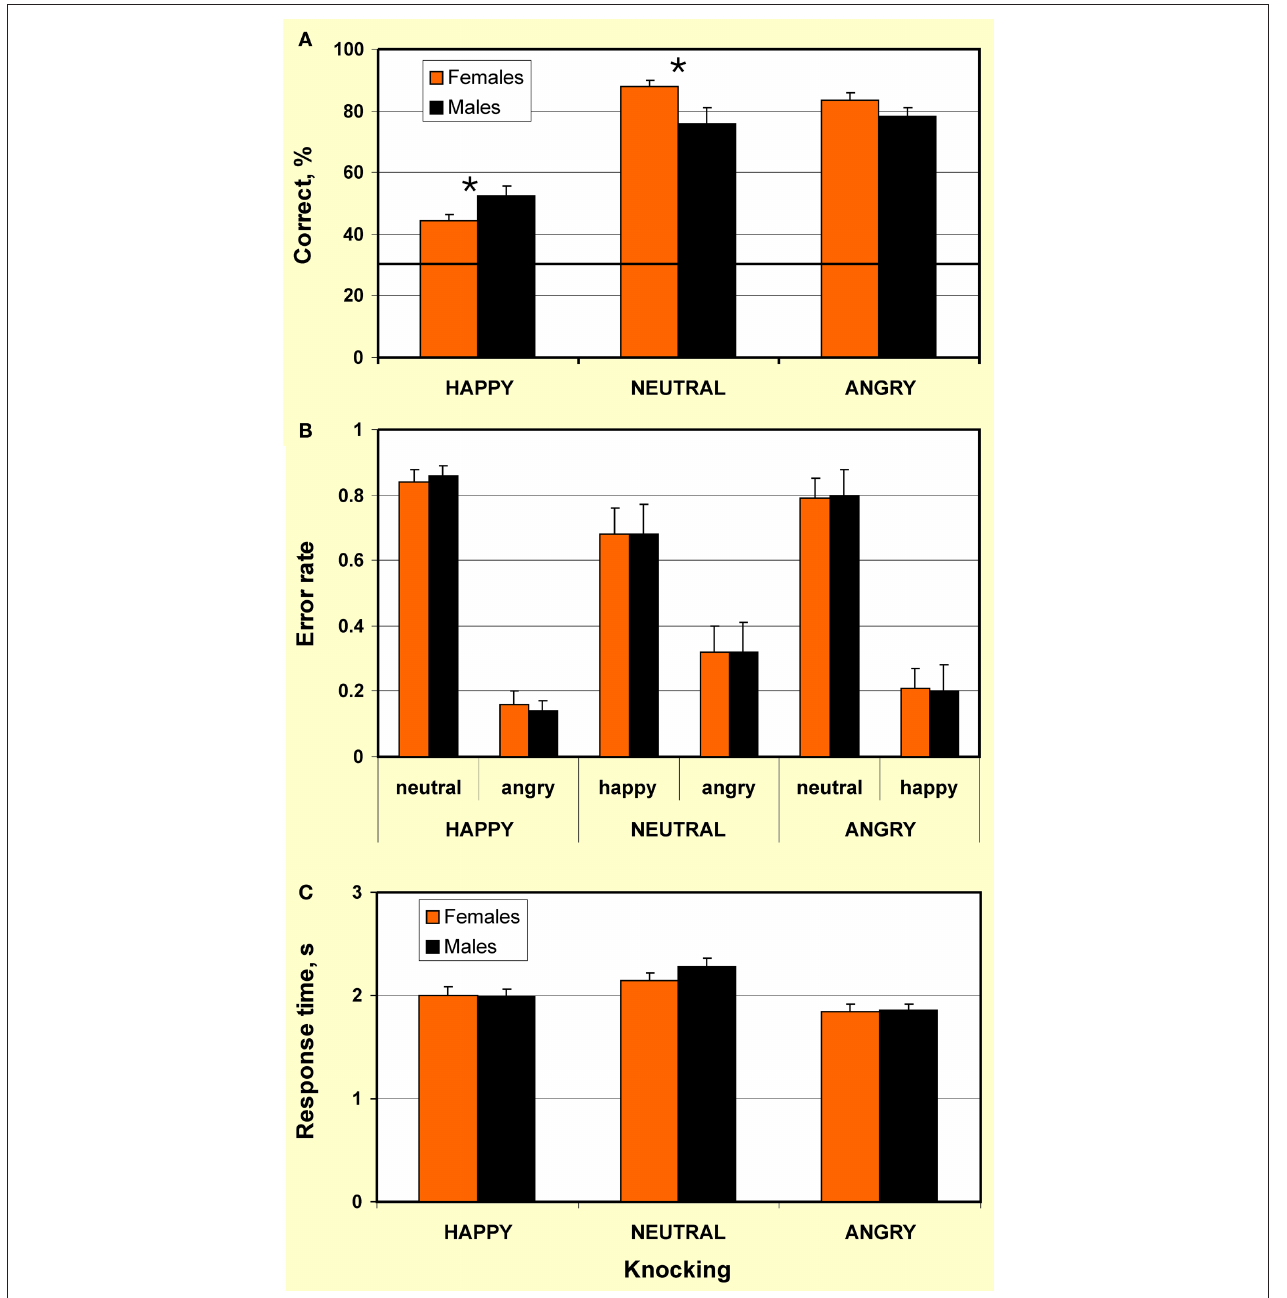
Figure 2 | recognition of happy, neutral, and angry point-light knocking by females and males. (A) Percentage correct: Males outperformed in recognition of happy knocking ( p < 0.015), whereas females excelled in recognition of neutral knocking ( p < 0.016) and tended to over-perform in recognition of angry knocking ( p < 0.07). Bold horizontal line indicates chance level. Significant differences are indicated by an asterisk; (B) Error rate: The lack of gender differences in error rate demonstrates that gender differences in recognition accuracy of emotional content of knocking were not caused by